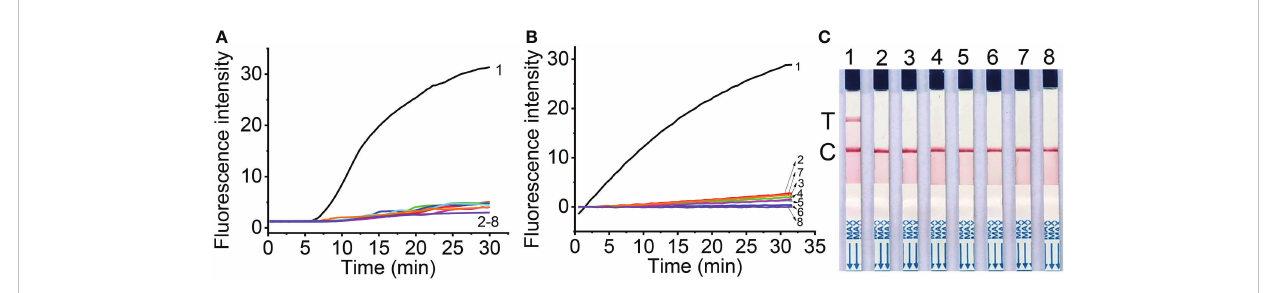
FIGURE 3 Speci fi city of real-time fl uorescent RT-RAA (A) , Cas12a mediated fl uorescent detection (B) and lateral fl ow assay (C) of RT-RAA pre-ampli fi cation products from total RNA. 1, Maize chlorotic mottle virus (MCMV); 2, Sugarcane mosaic virus (SCMV); 3, Cucumber mosaic virus (CMV); 4, Tobacco mosaic virus (TMV); 5, Tomato ringspot virus (TRSV); 6, Tomato black ring virus (TBRV); 7, healthy maize leaves; 8, DNase/RNase-free deionized